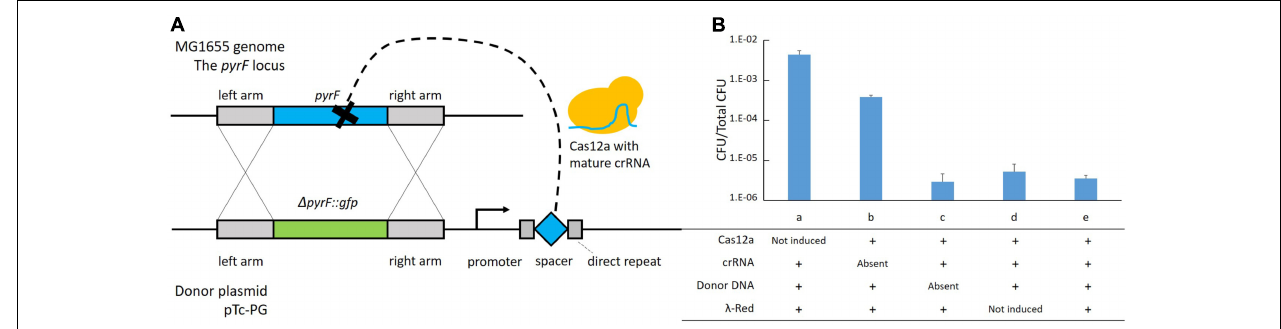
FIGURE 2 | Effects of different components in the two-plasmid system on inducible cell killing. (A) Diagram of the events during genome editing. (B) Effects of Cas12a, targeting crRNA, donor DNA and λ -Red in the two-plasmid system. The data represent the means ± standard deviations from three measurements for each experiment.